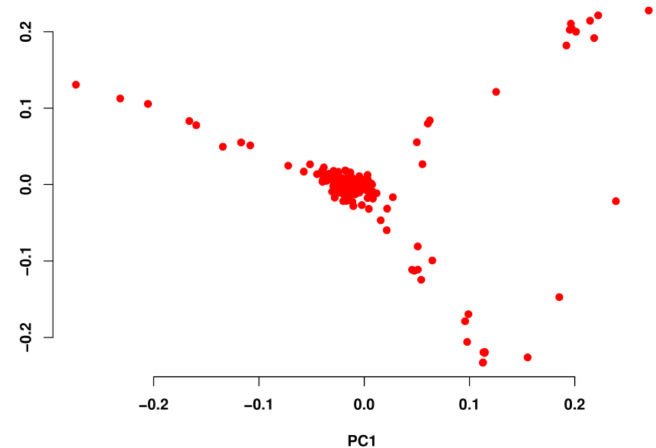
Figure 2. Principal component analysis (PCA) of the genomic relationship of the population of Dabieshan cattle (DBSC).